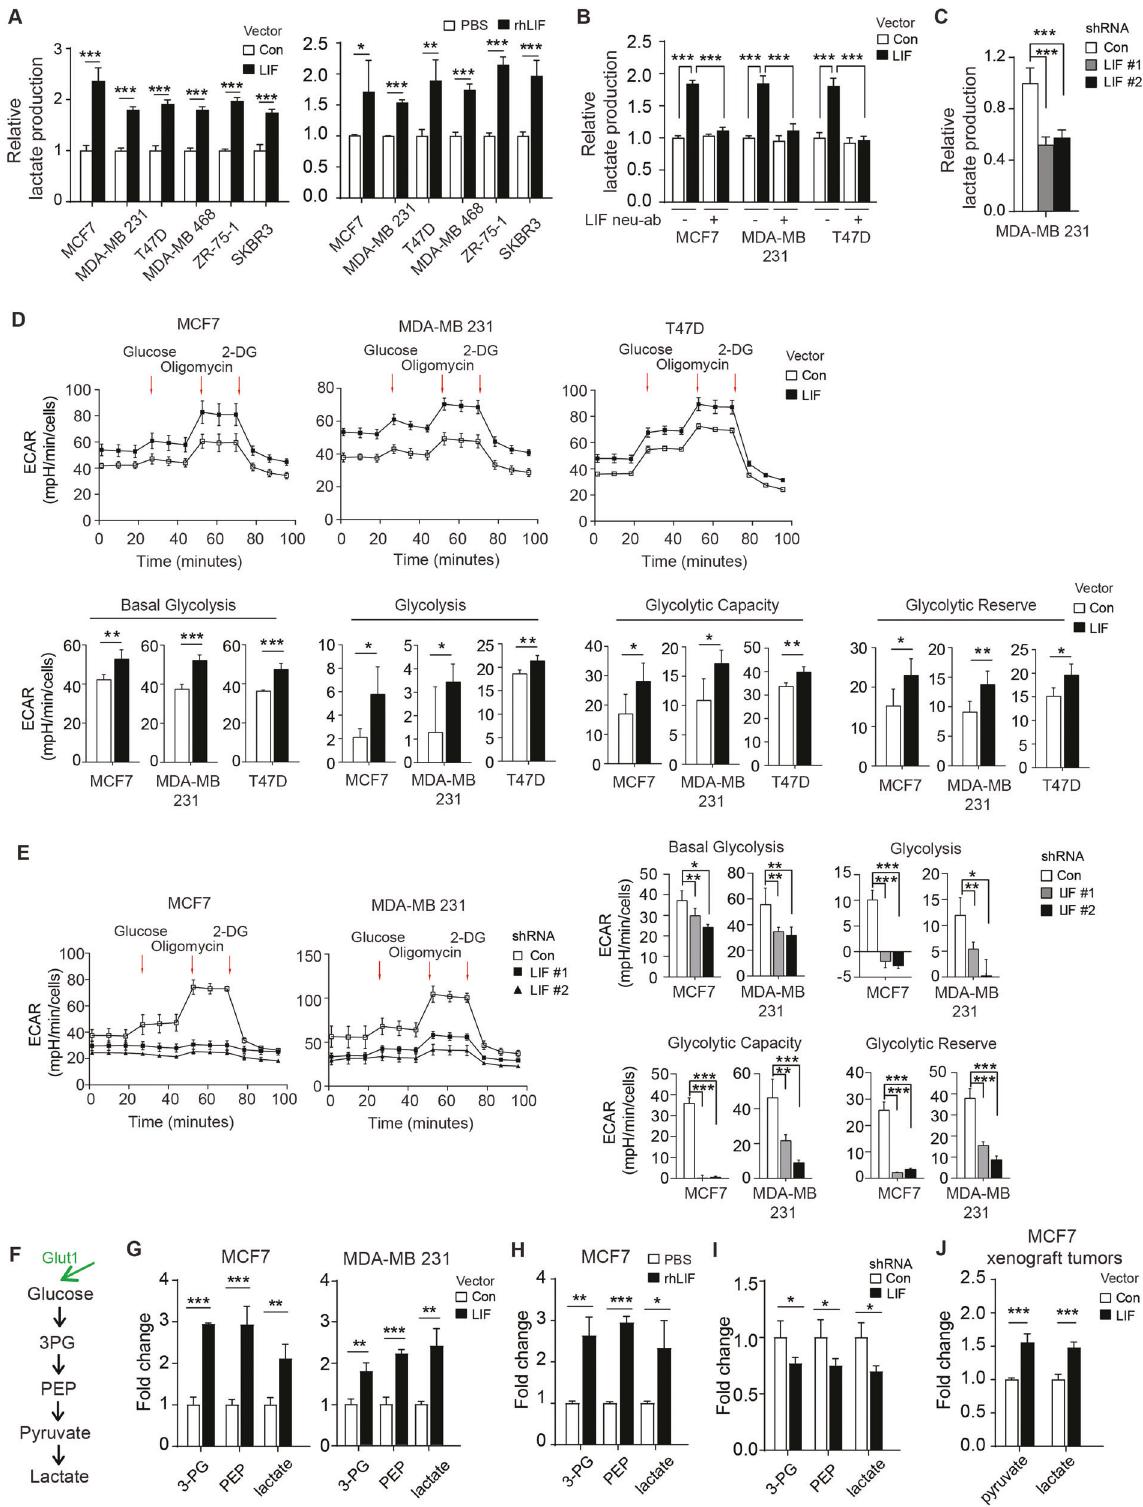
different breast cancer cell lines (Fig. 2A). The increased lactate production by LIF can be largely abolished by treating breast cancer cells with LIF neutralization antibody (LIF neu-ab) (Fig. 2B). Consistently, knockdown of LIF greatly decreased lactate produc- tion in MDA-MB 231 cells (Fig. 2C). Employing Seahorse Analyzer to measure extracellular acidi fi cation rate (ECAR) of cells as